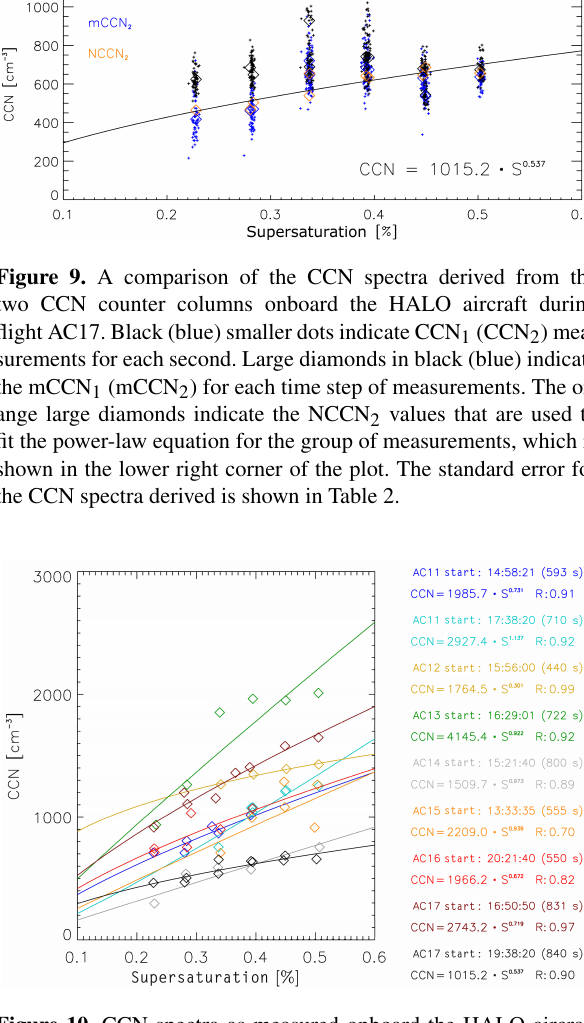
Figure 10. CCN spectra as measured onboard the HALO aircraft during cloud-profiling flights. The diamonds indicate the NCCN 2 values, which are used to fit the power-law equation for the group of measurements. The colors indicate the group of measurements and match the legend on the right side of the plot. The legend indicates the flight number, the initial time of group measurements, the period of measurements in seconds, the power-law fit, and the correlation coefficient of the data. The standard errors for each CCN spectrum derived are shown in Table